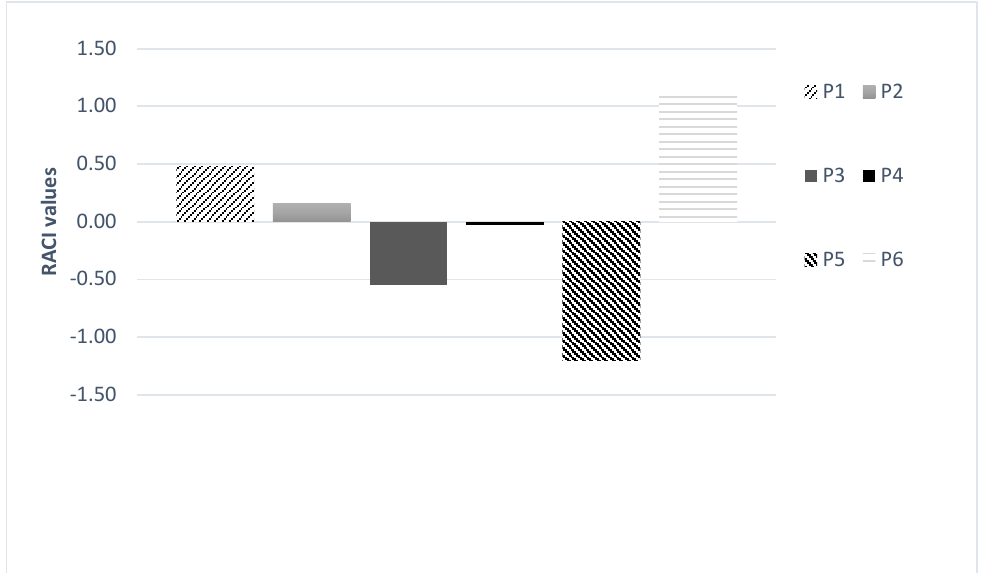
Figure 1. Relative Antioxidant Capacity Index (RACI) value of P. armeniaca (P1–P3) and P. domestica (P4–P6) essential oils.